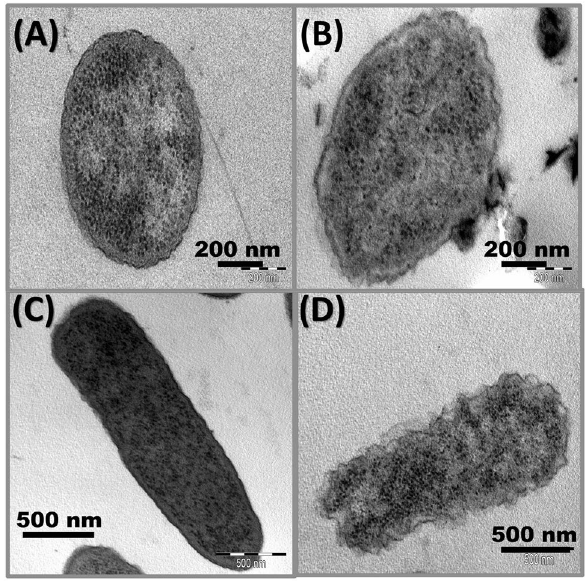
Figure 9. TEM images of S. aureus and E. coli in free LB medium ( A , C ) and after exposure to irradiated rosin of R-40 ( B , D ), respectively.